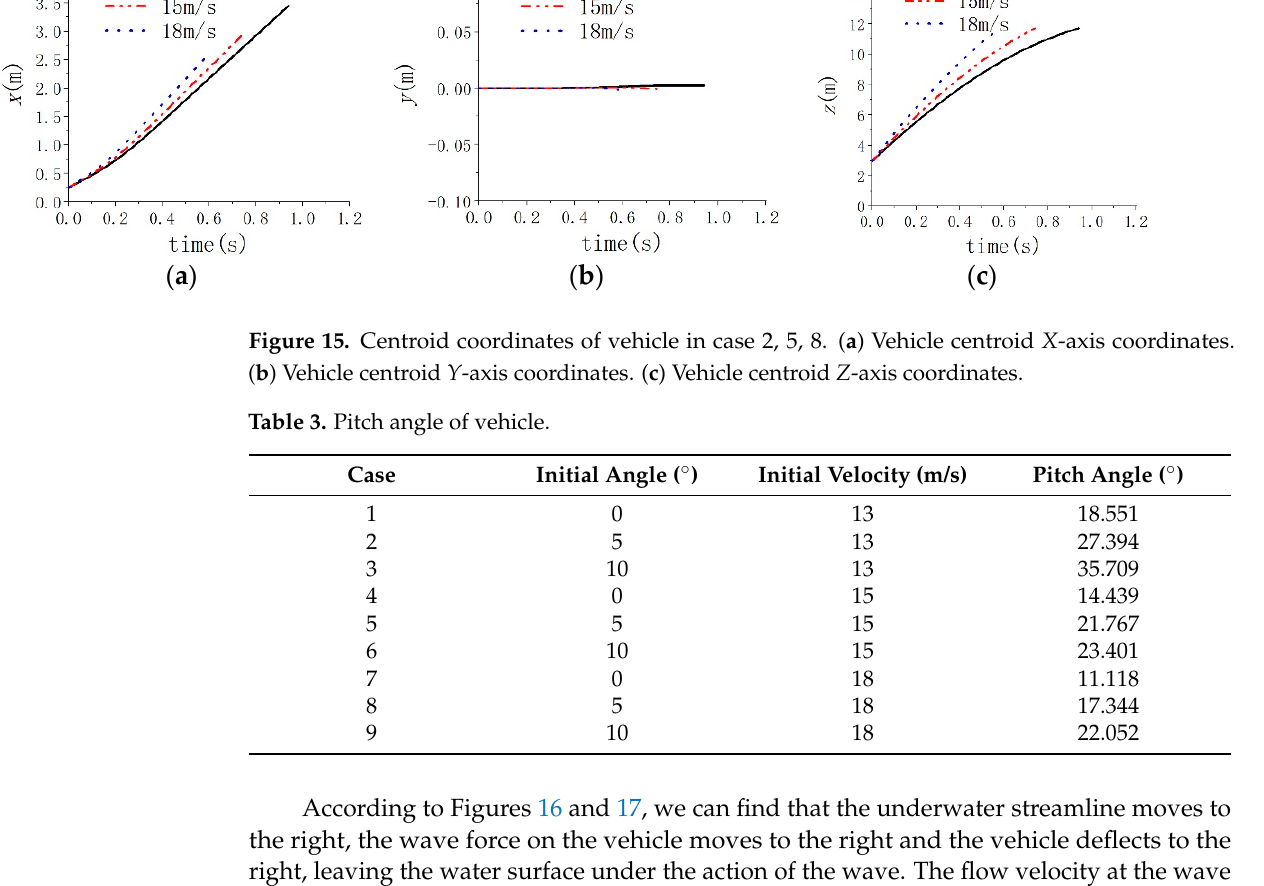
Vehicle centroid Y -axis coordinates. ( c ) Vehicle centroid Z -axis coordinates.